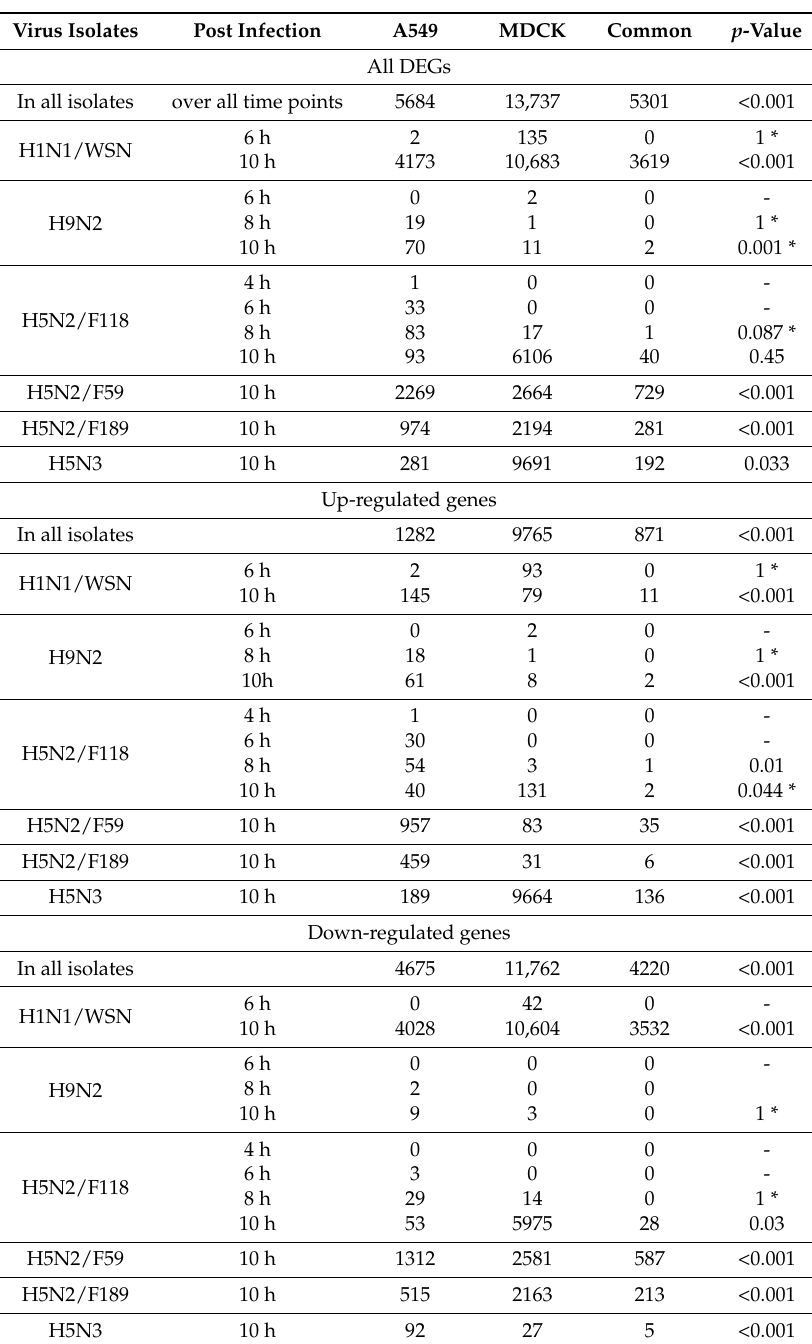
Table 3. Comparison of orthologous differentially expressed genes (DEGs) in influenza A virus (IAV) infected A549 and Madin-Darby canine kidney (MDCK)